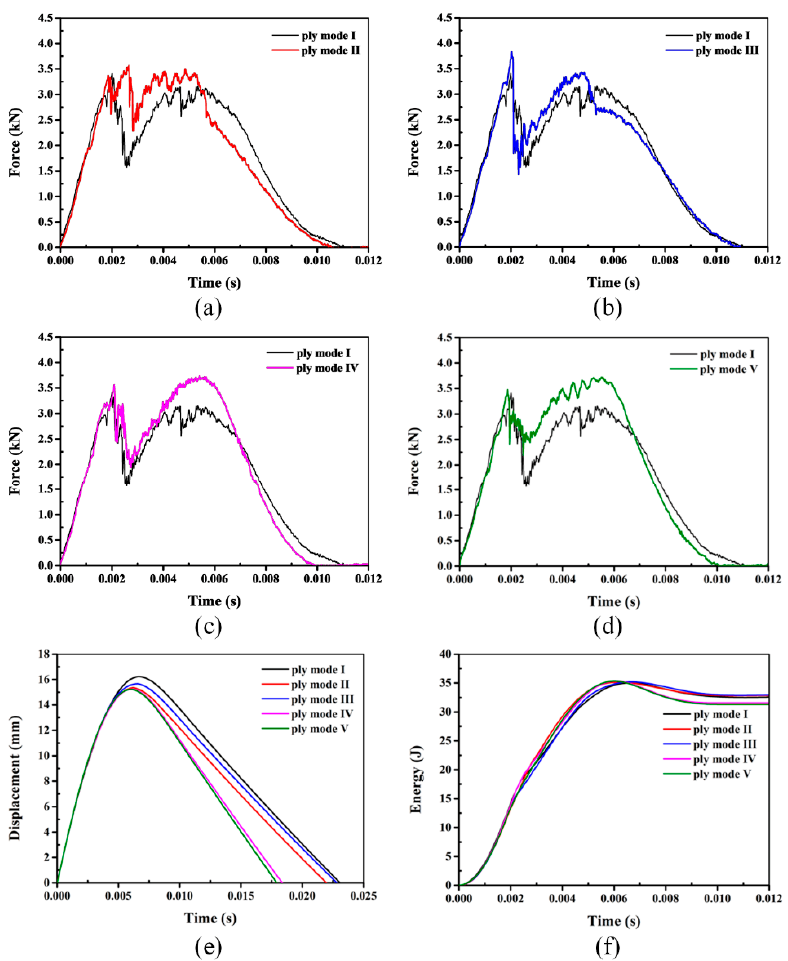
Figure 9. Typical impact responses of hybrid sandwich panels with one layer of SMA wires (( a–d ) represent the force-time curves of mode I with modes II, mode III, mode IV and mode V, respectively. ( e , f ) show the displacement-time and energy-time histories, respectively). Table 3. Impact responses of the sandwich panels without or with one layer of SMA wires.